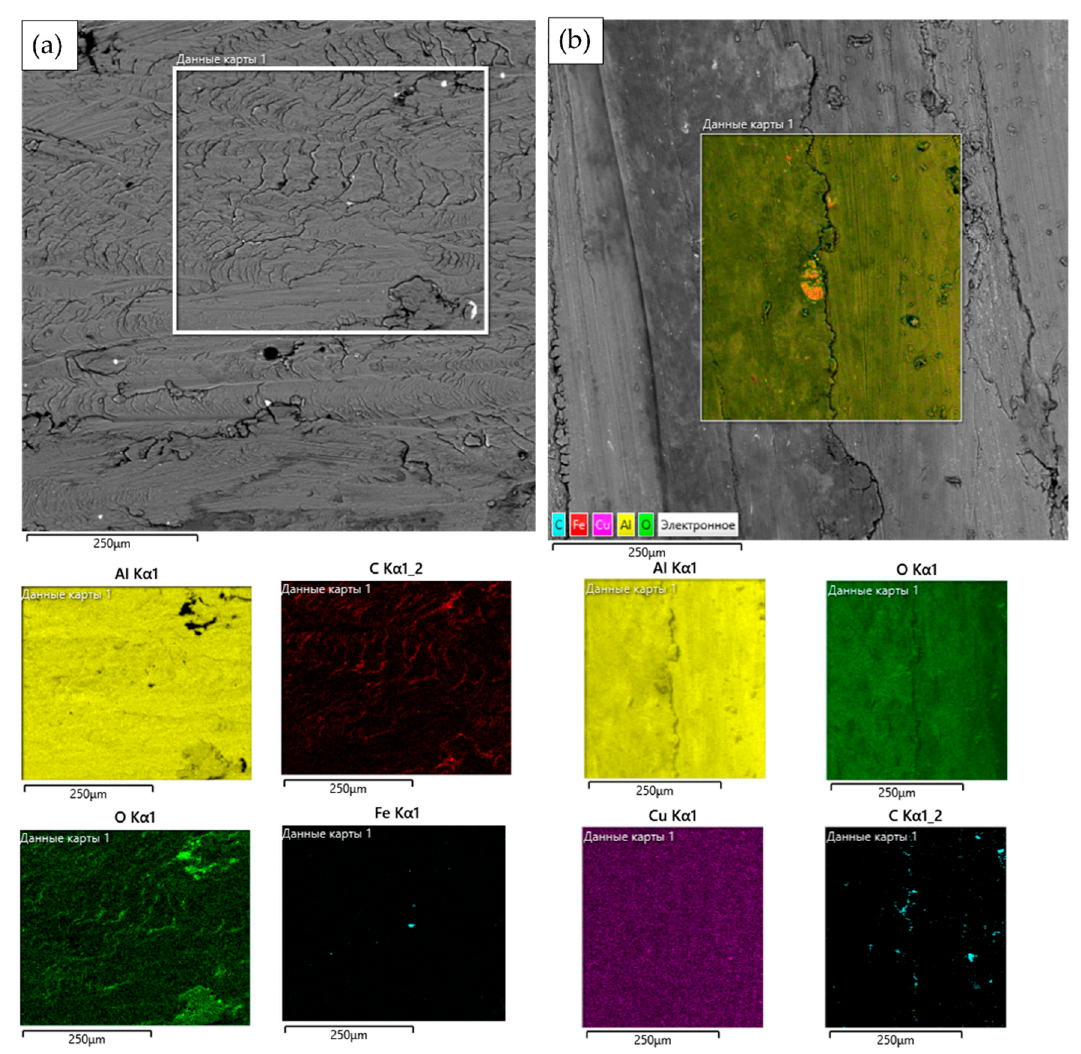
Figure 10. EDS analysis of the worn surfaces of the composites Al-2%f.s ( a ) and Al-2%f.s-2%Cu ( b ). A significant amount of oxygen was observed on the worn surface of the composites. However, on the worn surface of Al-2%f.s-2%Cu, oxygen was evenly distributed, in contrast to Al-2%f.s, where oxygen did not cover all of the surface but is present only in local segregations. This observation confirms the assumption that the oxide film of Al-2%f.s-2%Cu was not destroyed under this friction condition.